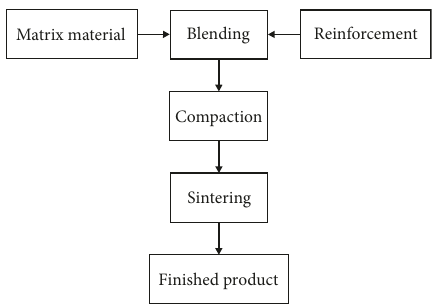
Figure 1: Powder metallurgy